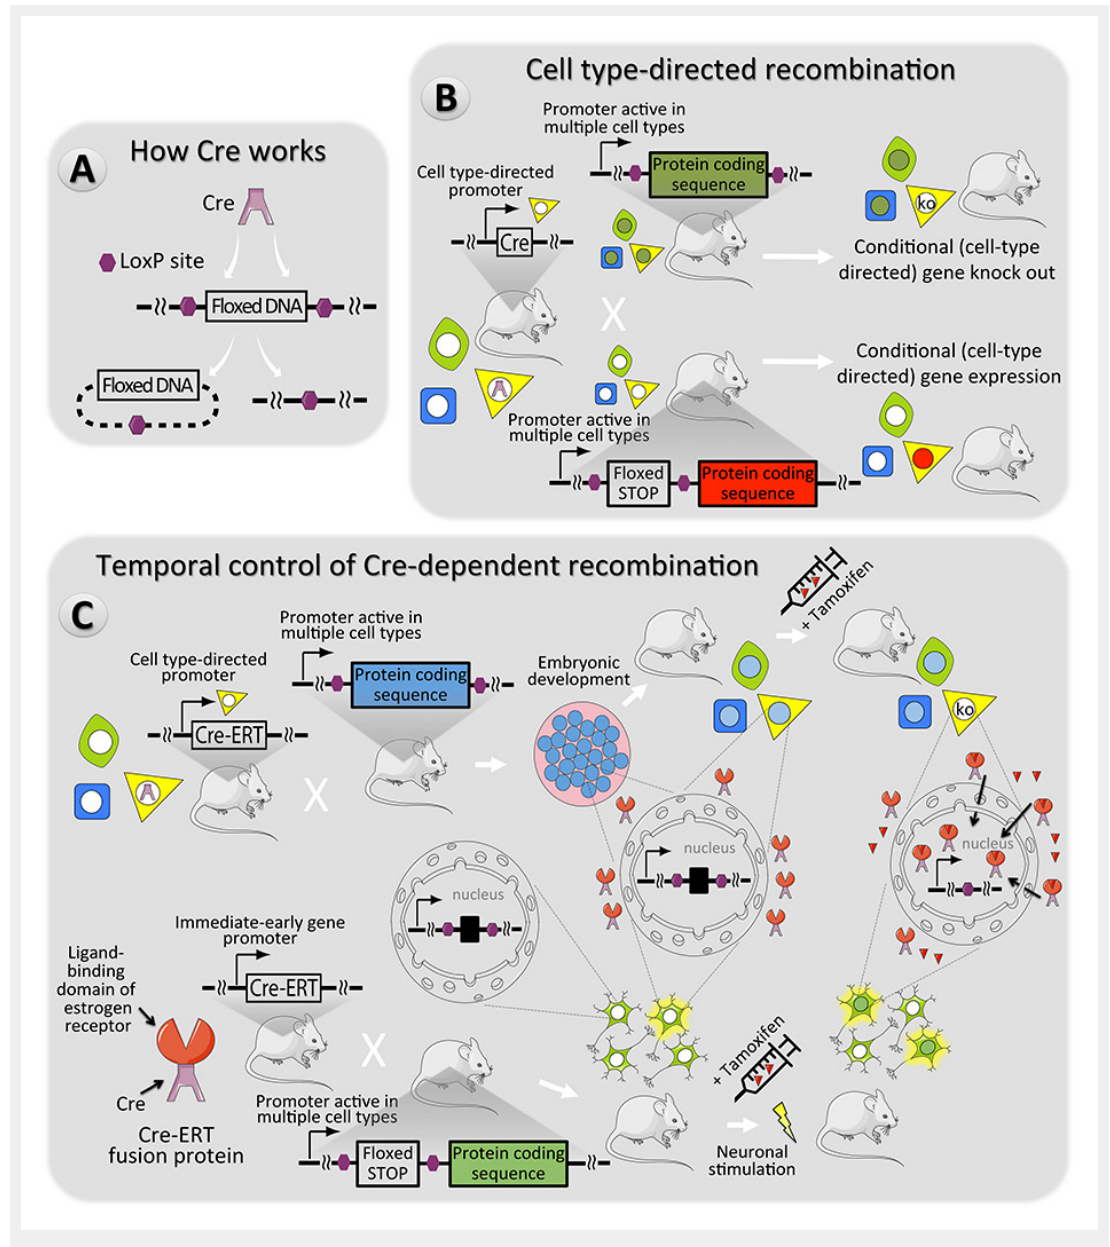
Cre recombinase – a versatile mouse genome manipulation tool. (A) In the systems described here, the activity of the Cre enzyme results in the removal of DNA sequences between two LoxP sites in the mouse genome [160]. (B) Spatially restricted expression of Cre can be employed to inactivate or activate genes in specific cell types [146] (cell type 3 – yellow). (C) Temporal control of Cre activity can be accomplished with fusion proteins consisting of Cre with an oestrogen receptor fragment (ERT) which prevents Cre-mediated recombination, until tamoxifen is present to direct the Cre-ERT fusion into the nucleus [161]. The top pathway features an example where the promoter driving Cre-ERT is cell type-specific. This is convenient in cases where cellular phenotypes change during development or through time (e.g. neural precursor cells can become neurons or glia). The bottom pathway features an example where Cre-ERT expression is induced by stimuli that happen often but when Cre activity is desired for a specific time. In this example an immediate early gene promoter drives expression, which would happen often, but Cre activity would occur only when tamoxifen is present